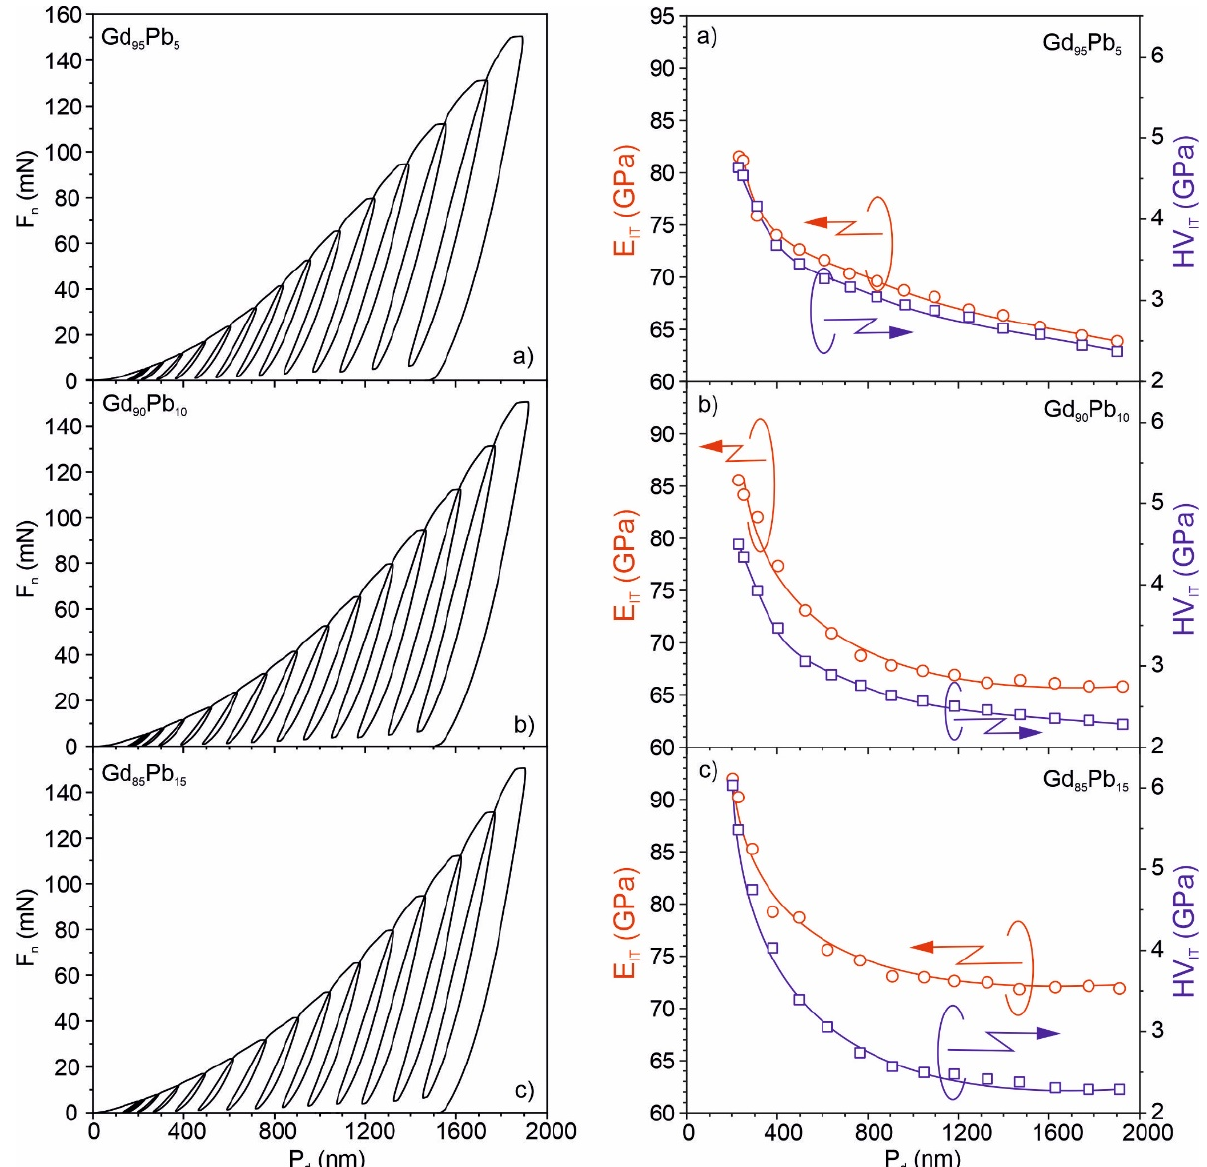
Figure 12. Continuous Multi Cycle load (F n ) versus indentation penetration depth (P d ) curve, and corresponding Young’s modulus (E IT ) and hardness (H IT ) for the Gd-rich phases discovered in Gd 95 Pb 5 ( a ), Gd 90 Pb 10 ( b ) and Gd 85 Pb 15 ( c ) alloys.